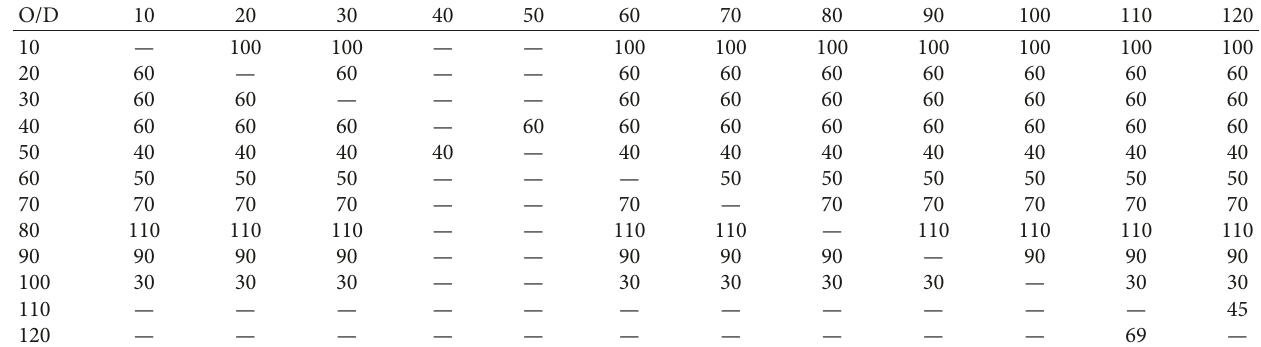
Table 4: O-D demand matrix for Test Network-2 (veh/hr).